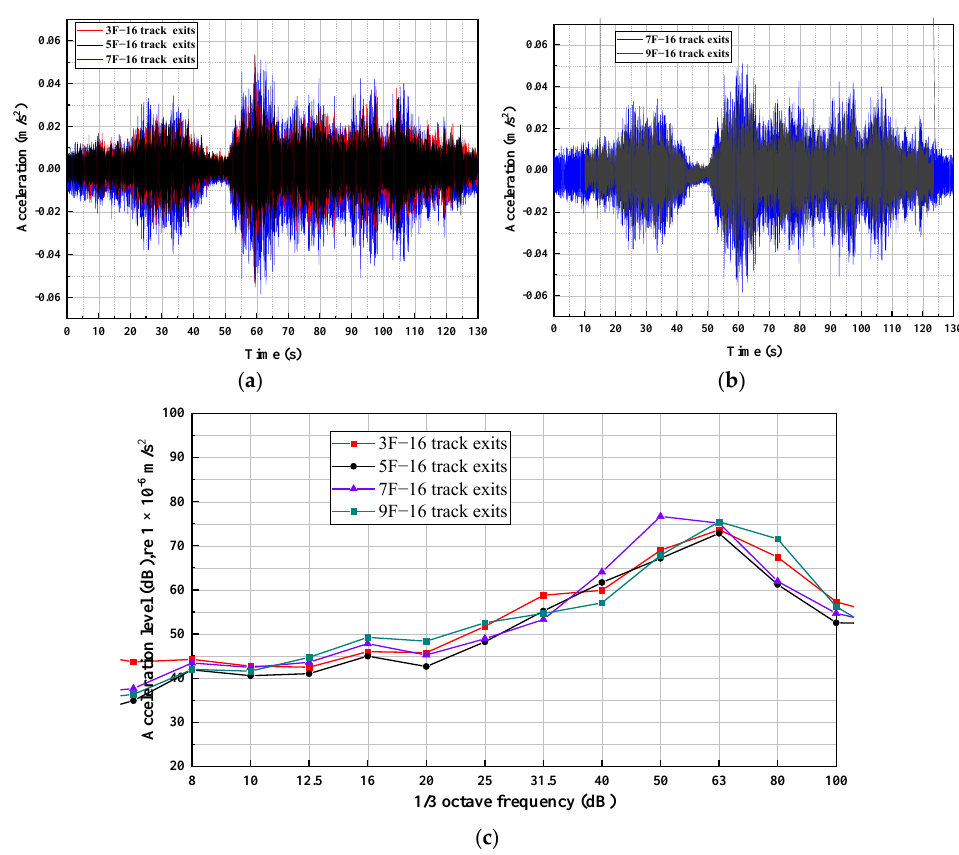
Figure 10. Analysis results of the vibration effect on human comfort on different floors in the time and frequency domains when the train exits track 16. ( a ) Time domain diagrams of measurement points on the 3rd, 5th and 7th floors; ( b ) Time domain diagrams of measurement points on the 7th and 9th floors; ( c ) One-third octave frequency diagrams of measurement points on the 3rd, 5th, 7th, and 9th floors.